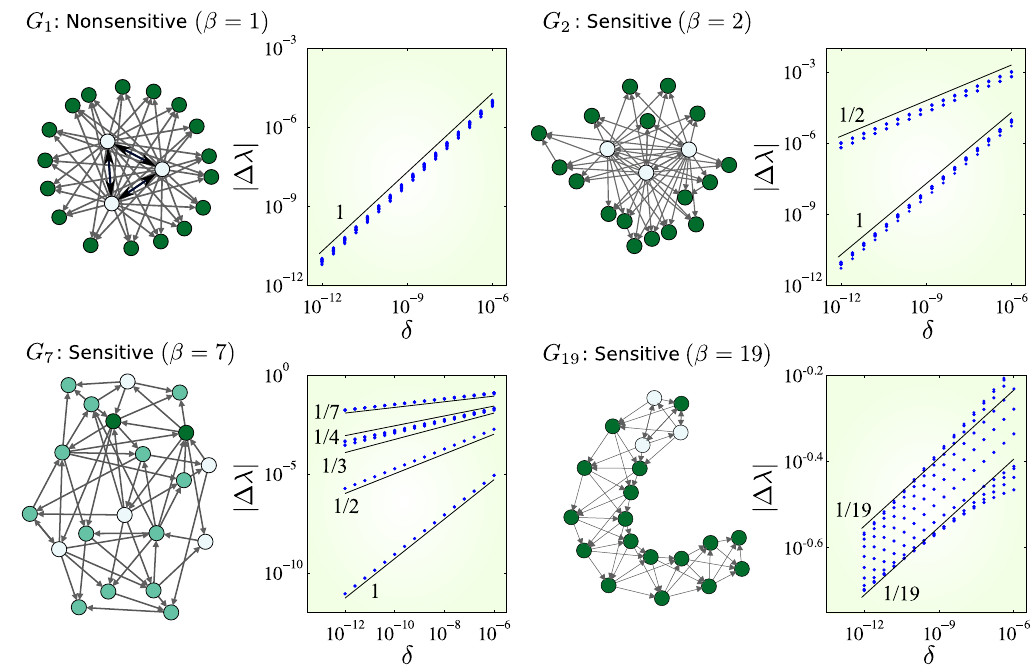
FIG. 7. Optimal directed networks with various levels of sensitivity to generic weighted perturbations. Example networks G 1 , G 2 , G 7 , and G 19 (each with 20 nodes and 57 links) all satisfy λ 2 ¼ (cid:2) (cid:2) (cid:2) ¼ λ 20 ¼ 3 (and thus are optimal) but have different geometric degeneracy. Perturbing the adjacency matrix of each network as A þ δ Δ A , we plot in double logarithmic scale the resulting change j Δ λ ð δ Þj ¼ j λ ð δ Þ − 3 j for all 19 Laplacian eigenvalues (blue dots, many of which are overlapping). The same randomly chosen Δ A is used for all four networks, where each Δ A ij is drawn uniformly from the interval ½ − 1 ; 1 (cid:4) if the link exists from node j to node i , and from [0, 1] otherwise. The perturbations thus allow small increase and decrease of the weight of existing links, as well as the addition of new links with small weight. In each network, nodes of the same color indicates the same in-degree, and a bidirectional arrow represents two directed links in opposite directions. The three nodes in the center of G 1 form a fully connected triangle and each of the other nodes has three in-links from these center nodes. In each plot, we observe the expected scaling behavior in Eq. (20), indicated by black lines, each labeled with the corresponding scaling exponent, 1 = β j ( G 1 : β ¼ 1 with 19 eigenvectors and β 1 ¼ (cid:2) (cid:2) (cid:2) ¼ β 19 ¼ 1 ; G 2 : β ¼ 2 with 15 eigenvectors and β 1 ¼ (cid:2) (cid:2) (cid:2) ¼ β 11 ¼ 1 , β 12 ¼ (cid:2) (cid:2) (cid:2) ¼ β 15 ¼ 2 ; G 7 : β ¼ 7 with 7 eigenvectors and β 1 ¼ β 2 ¼ β 3 ¼ 1 , β 4 ¼ 2 , β 5 ¼ 3 , β 4 , β 7 ; G β ¼ 19 with 1 eigenvector and β 19 6 ¼ 7 ¼ 19 : 1 ¼